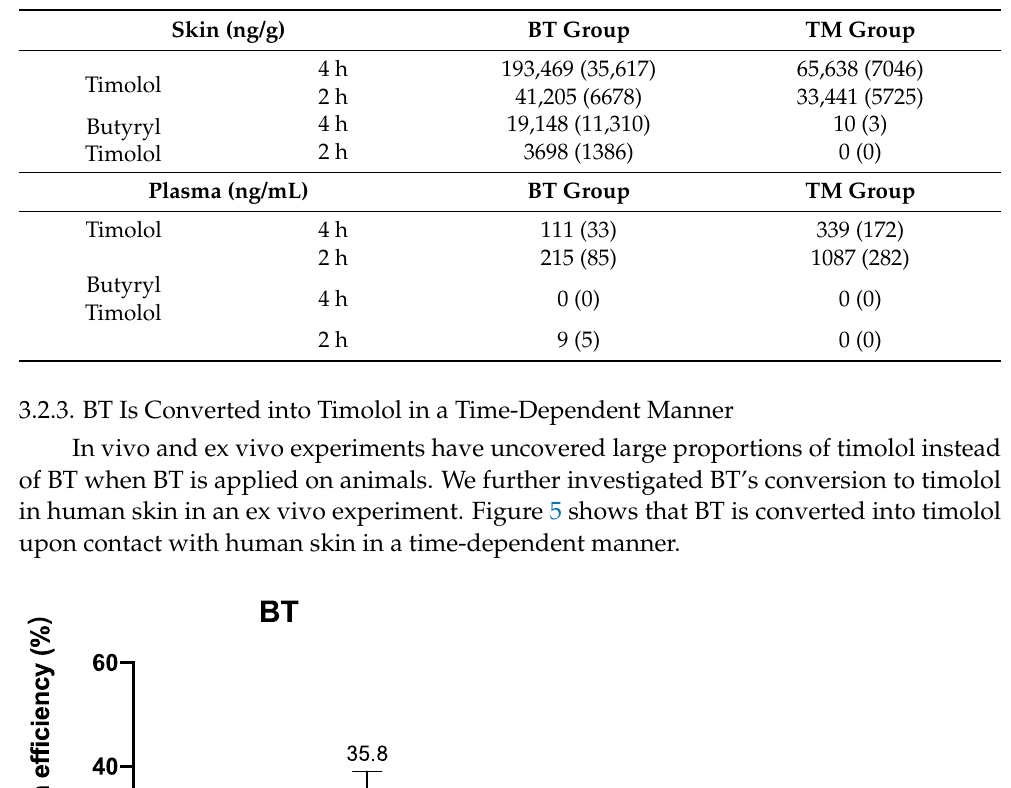
Table 1. In vivo skin and plasma drug concentrations after topical TM and BT application on SD rat skin. All data are presented as the mean (SD) (n = 3).